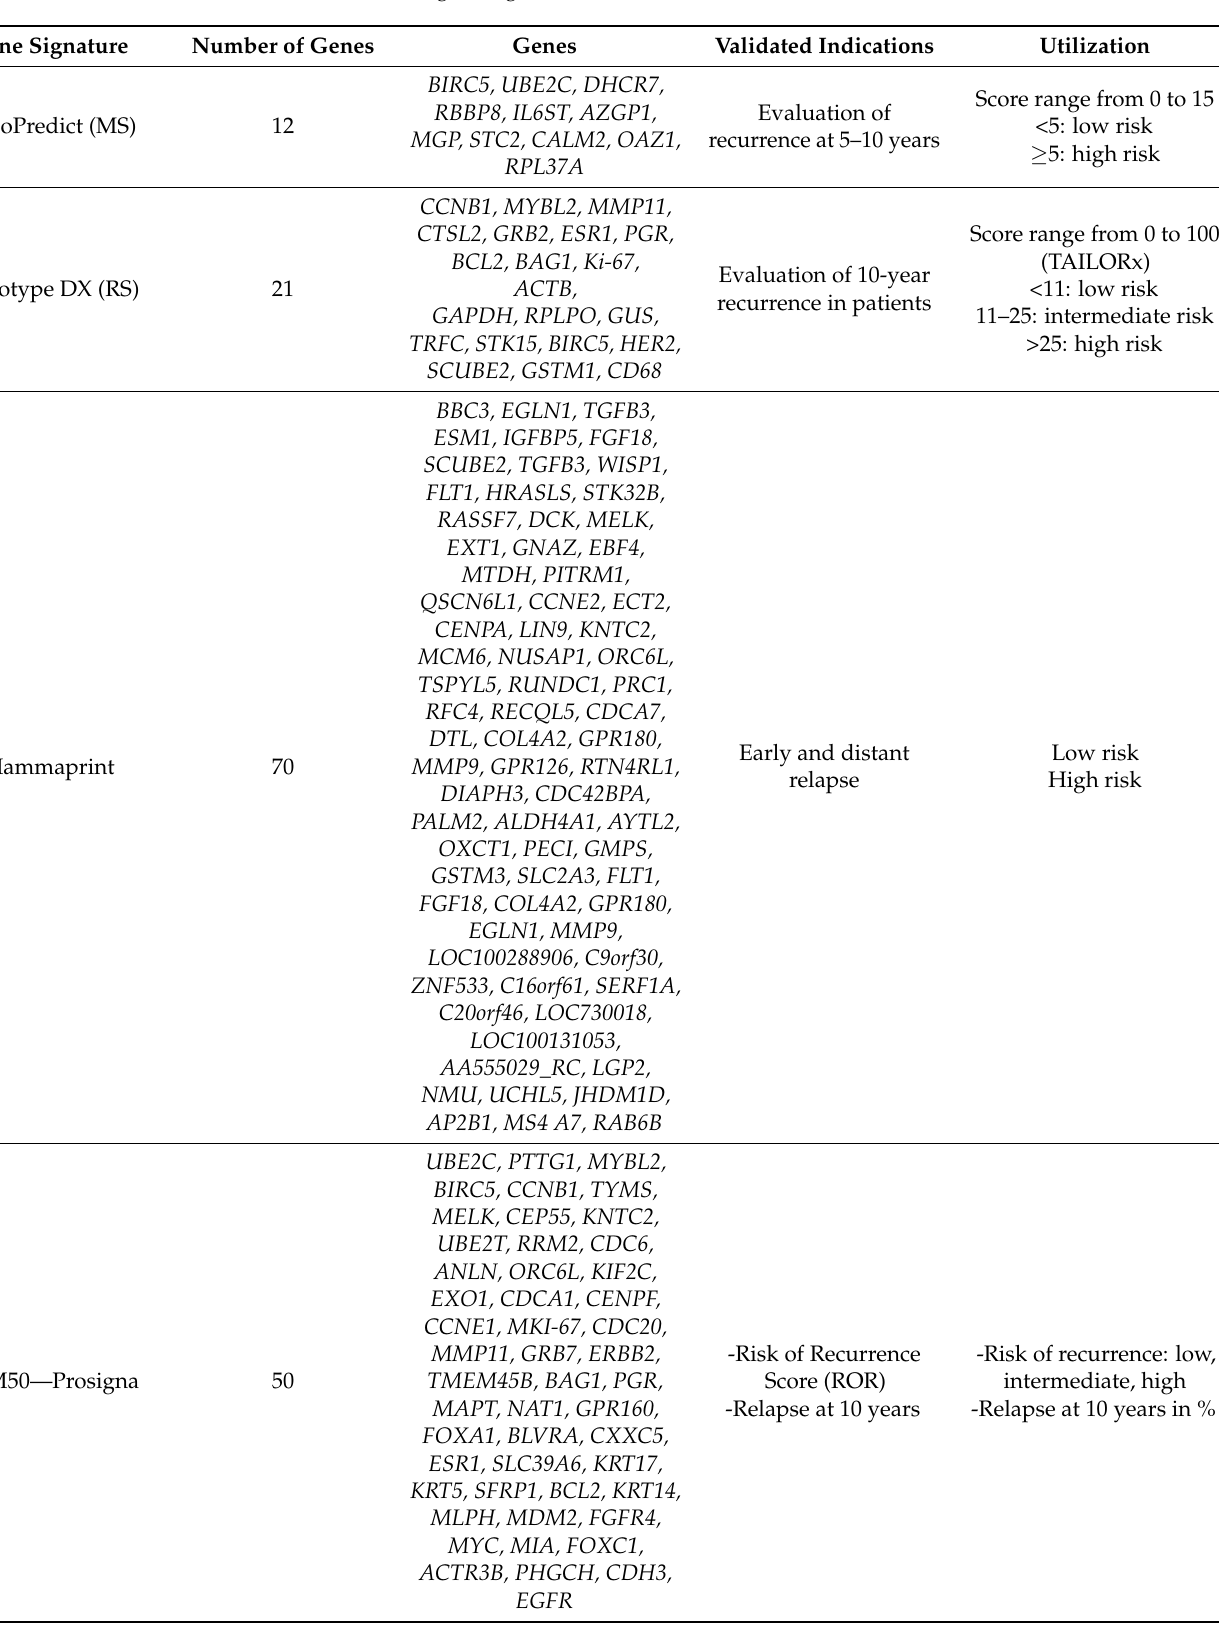
Table 4. Available gene signatures and their current